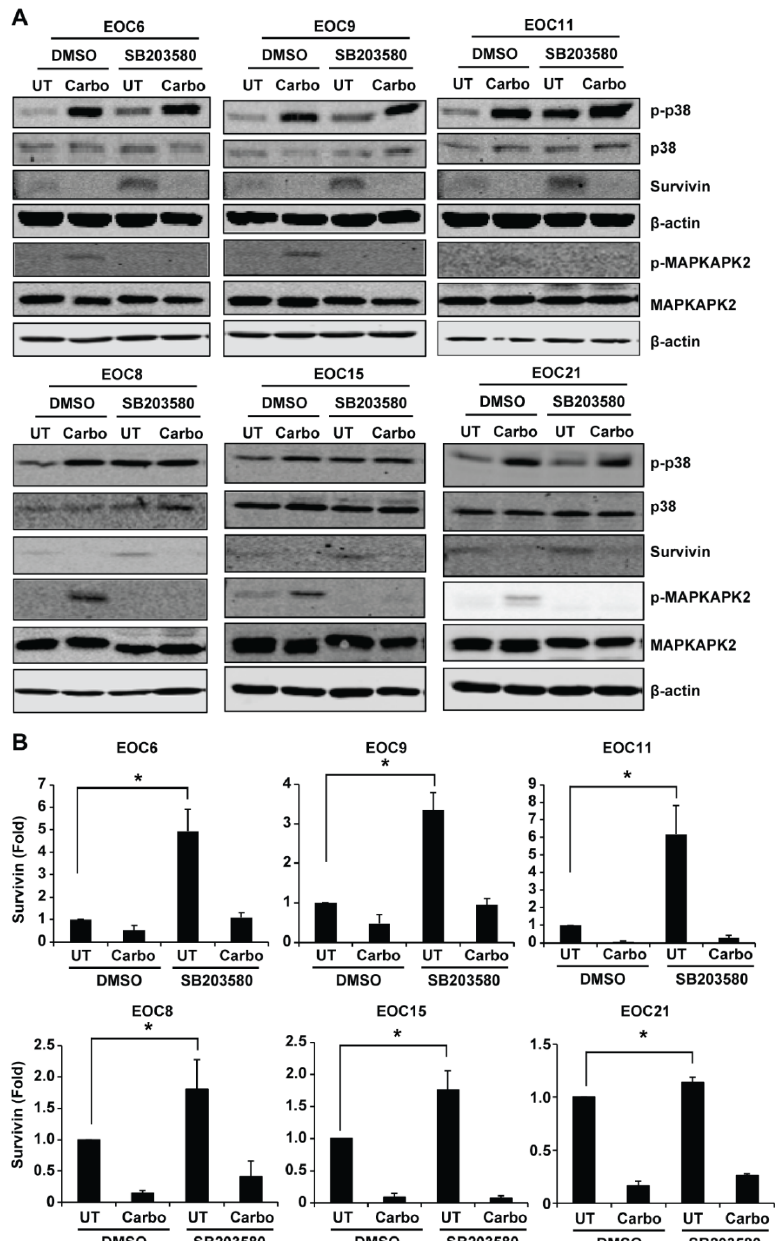
Figure 5 . Inhibition of p38 MAPK by SB203580 increases survivin expression in primary EOC cells. Primary EOC cells were left untreated or treated with 200 µ M carboplatin in the presence of SB203580 (10 μ M) or an equal volume of DMSO (the vehicle control) for 48 h. ( A ) Phosphorylation of p38 MAPK and MAPKAPK2 (a direct substrate target of p38 MAPK), as well as survivin were examined by Western blotting. β‐ actin was used as the loading control. ( B ) The Western blotting results of survivin were quantified using Odyssey imaging software. The density of the survivin bands was normalized to that of β‐ actin. The density of the bands in the DMSO/UT cells was designated as 1. The relative level (fold change) of survivin was shown as mean ± SE of three to six independent experiments. * Significantly different ( p < 0.05).